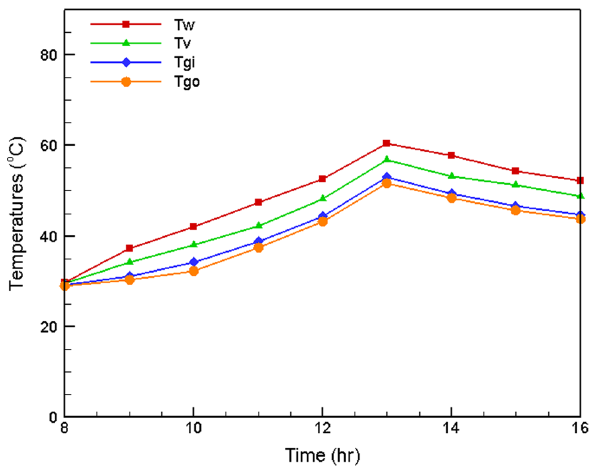
Figure 8: Variation of the CS temperatures with time.